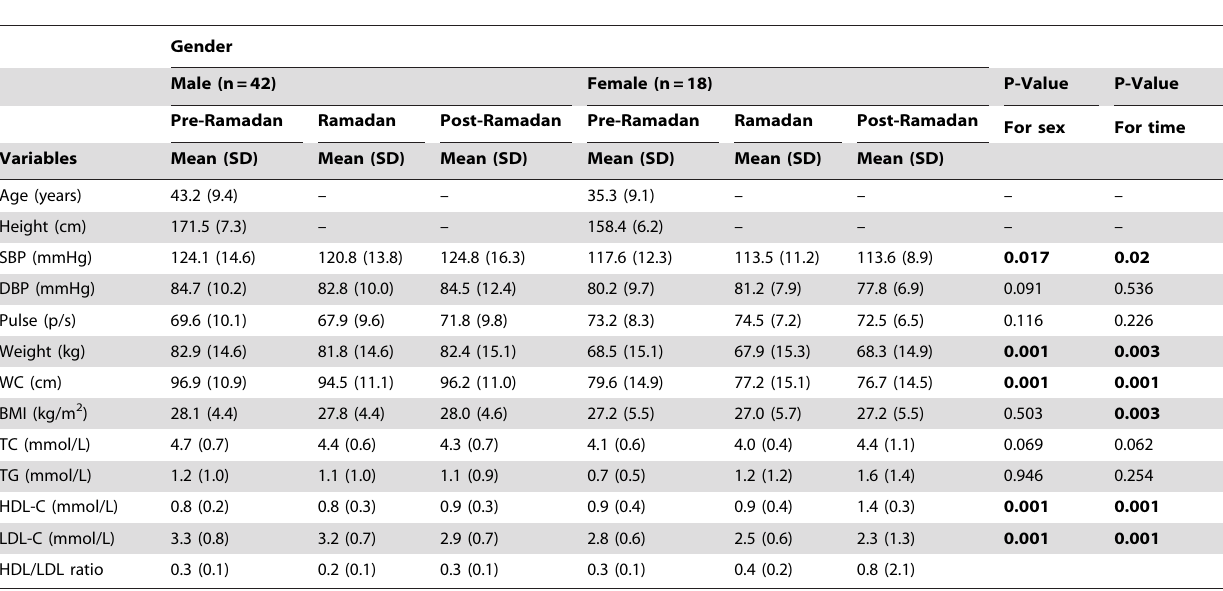
Table 1. Comparison of changes in blood pressure, Wt, WC, BMI, lipids, and lipoproteins levels before Ramadan (pre-Ramadan), Ramadan, and four weeks after Ramadan (post-Ramadan); using MIXED ANOVA. (n=65).